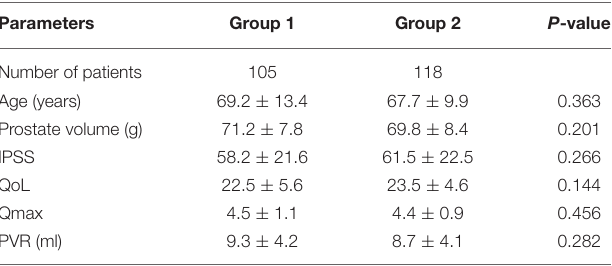
TABLE 1 | Comparison of baseline parameters and primary perioperative outcomes between the 2 groups. Parameters